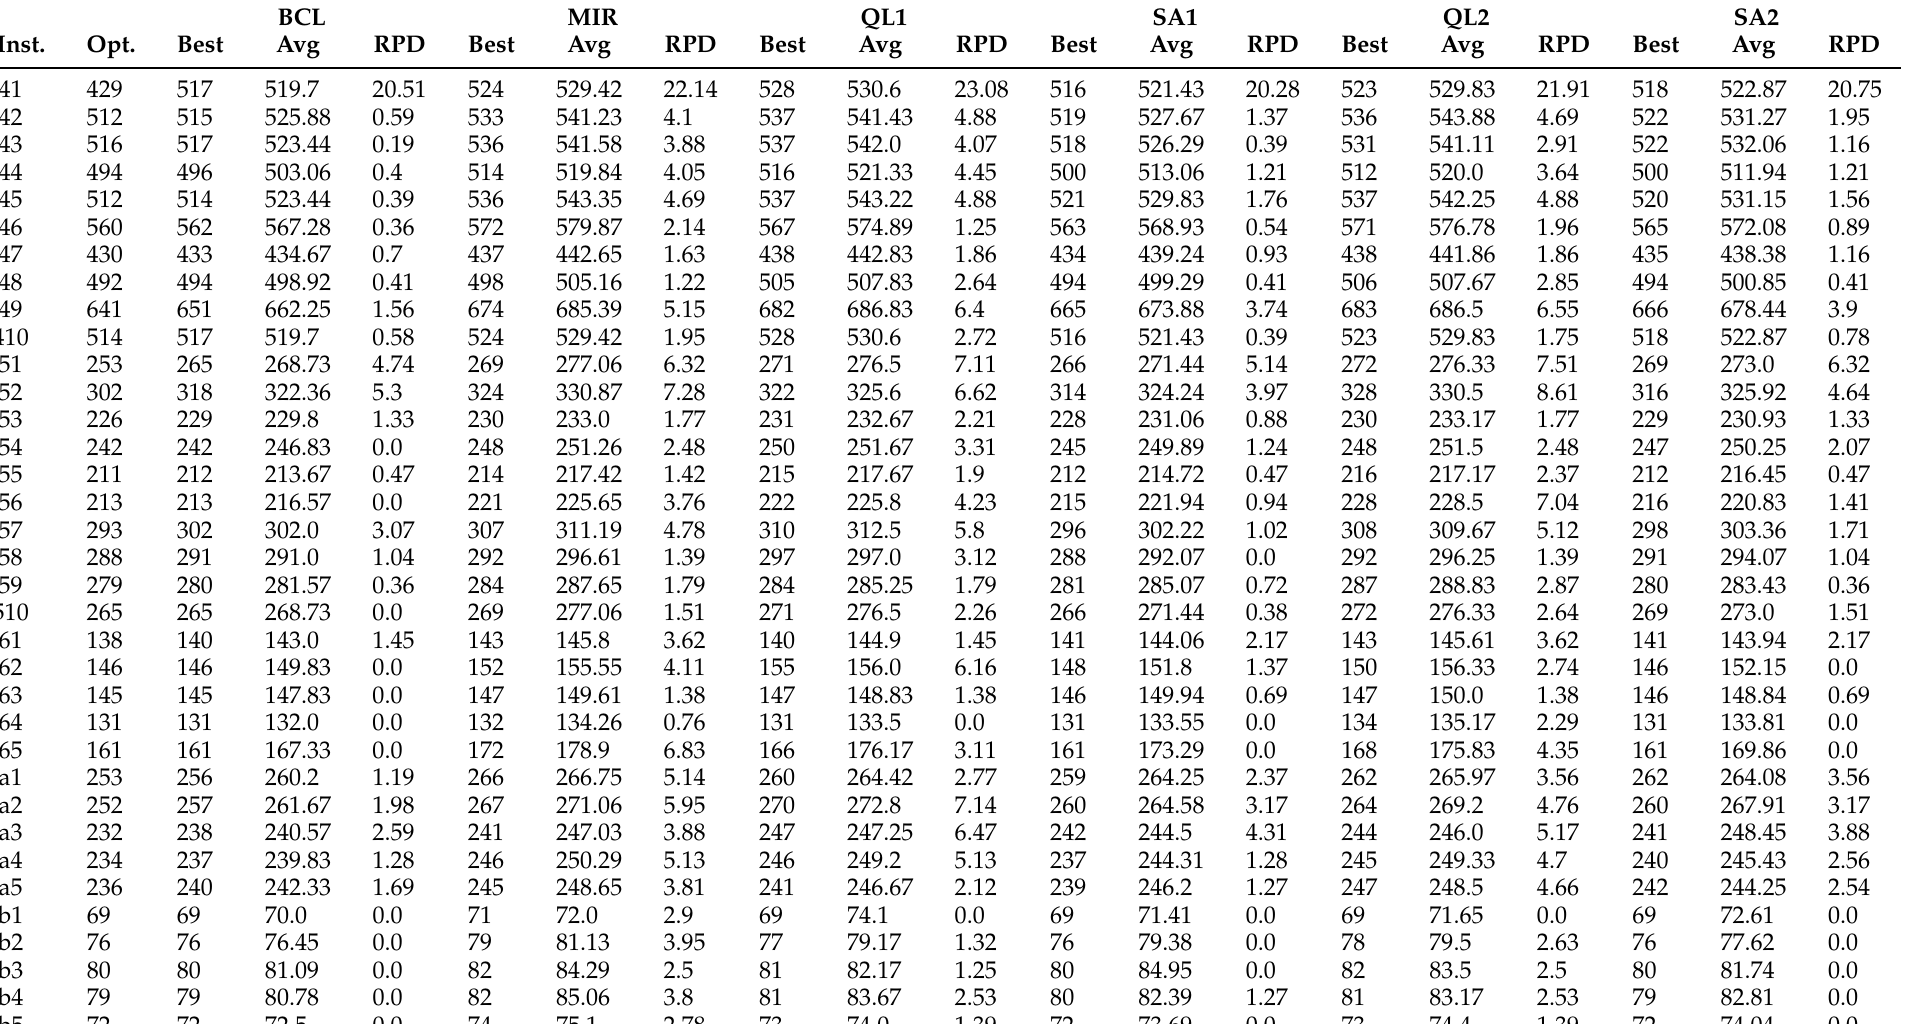
Table 11. Result comparison with GWO employing the approaches BCL, MIR, QL1, SA1, QL2, and